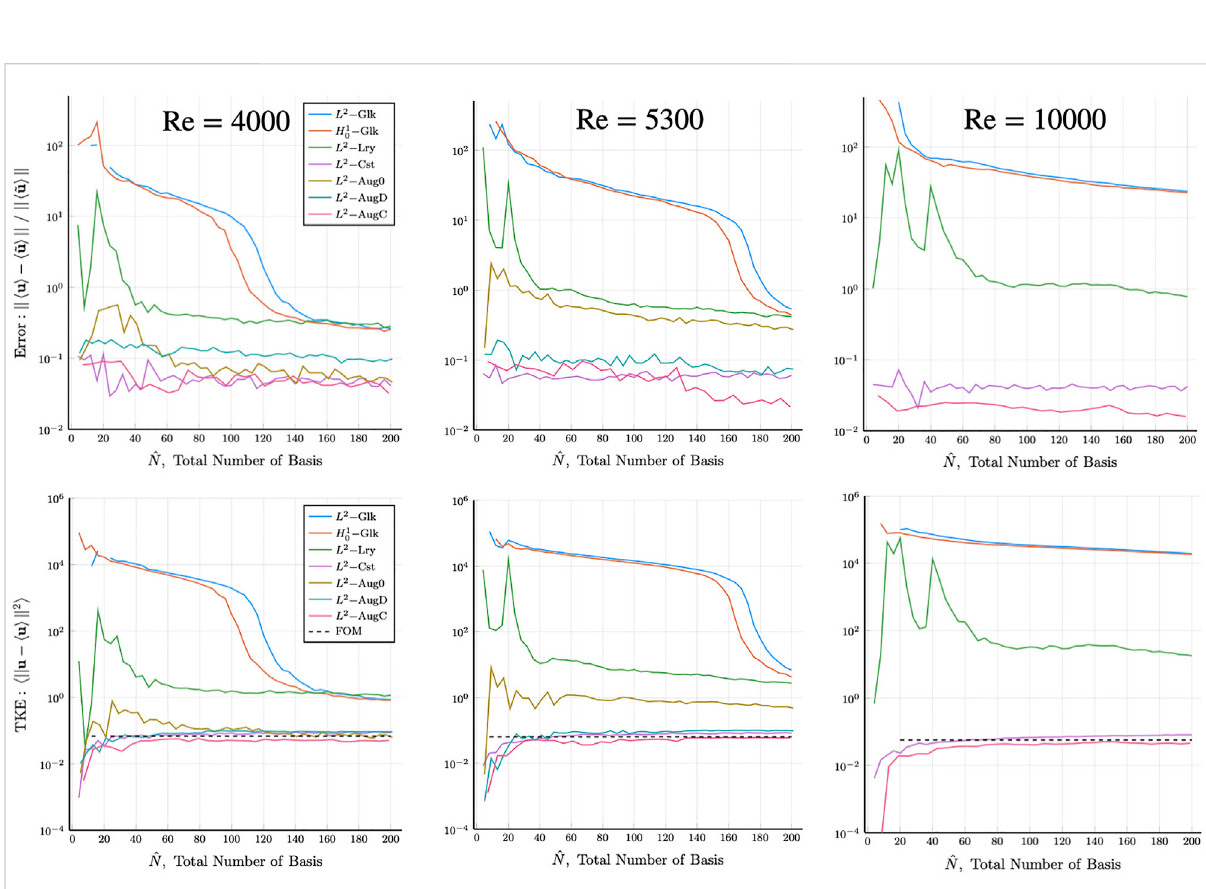
FIGURE 9 Pipe fl ow mean velocity error (top) and TKE results (bottom), for Re = 4,000, 5300, and 10,000 (FOM: τ = 50, ROM: τ = 500), curve broken by blowup